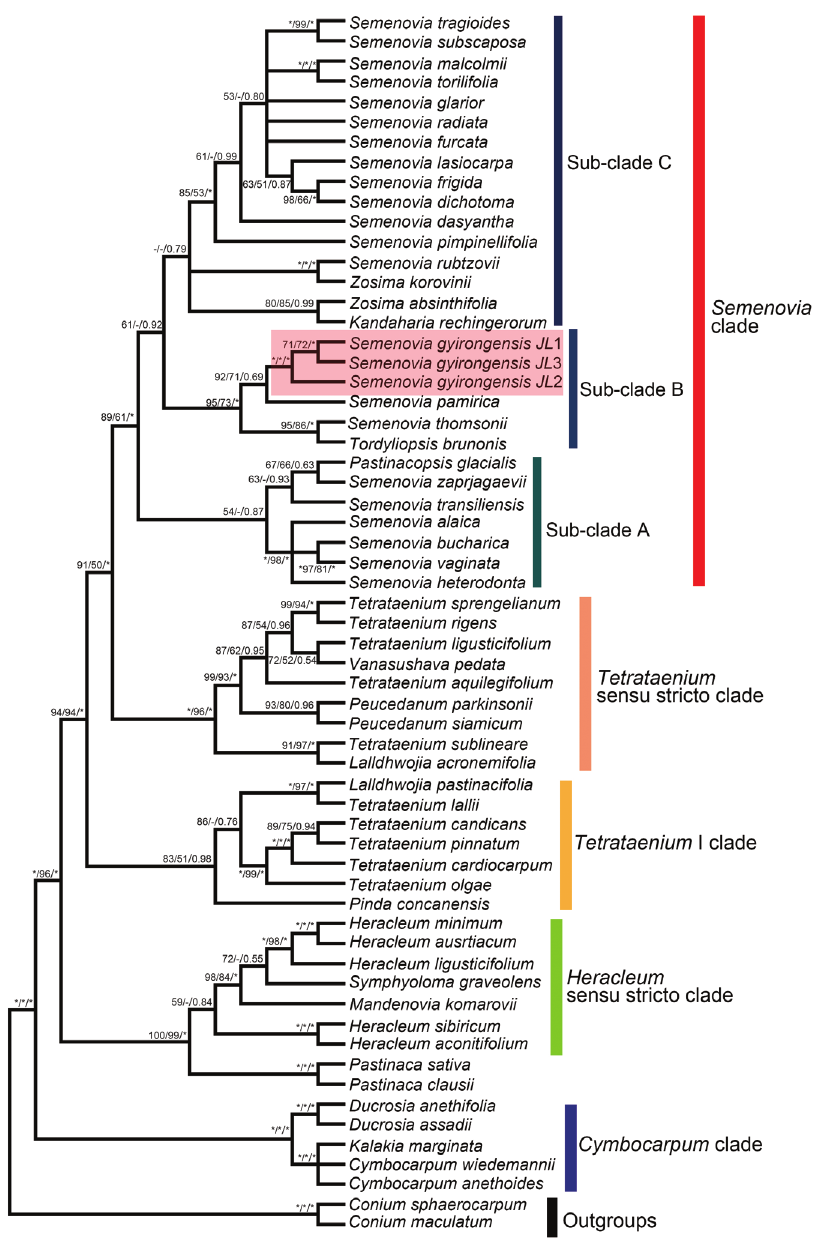
Figure 3. Phylogenetic tree inferred from tribe Tordylieae and outgroups of combined ITS/ETS dataset based on Bayesian inference (BI) method. The names of the major clades follow the study of Logacheva et al. (2010). Support values only those greater than 50% ML-BS, 50% MP-BS and 0.5 BI-PP are shown along the branches. Numbers on the branches indicated ML-BS/ MP-BS/ BI-PP, respectively. Asterisks denoted (*) the values of 100/100/1.00 for ML-BS/ MP-BS/ BI-PP. Dshes (-) indicated ML-BS and MP- BS values